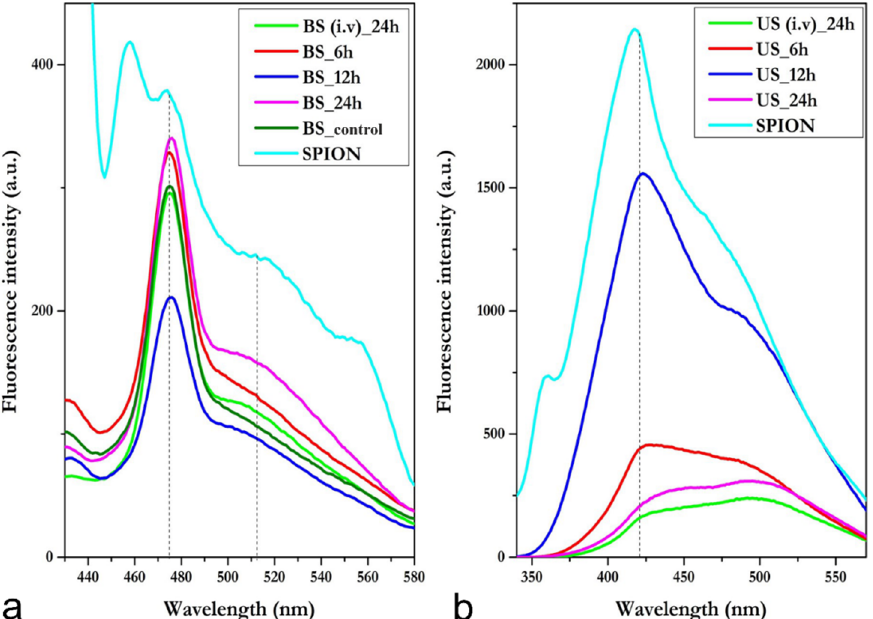
Figure 2. The fluorescence spectra of blood ( a ) and urine ( b ) samples collected at 6, 12, and 24 h post-intraperitoneal administration and 24 h post-intravenous administration of SPION-PEG clusters. BS— blood samples and US—urine samples, collected at different time periods, control—untreated